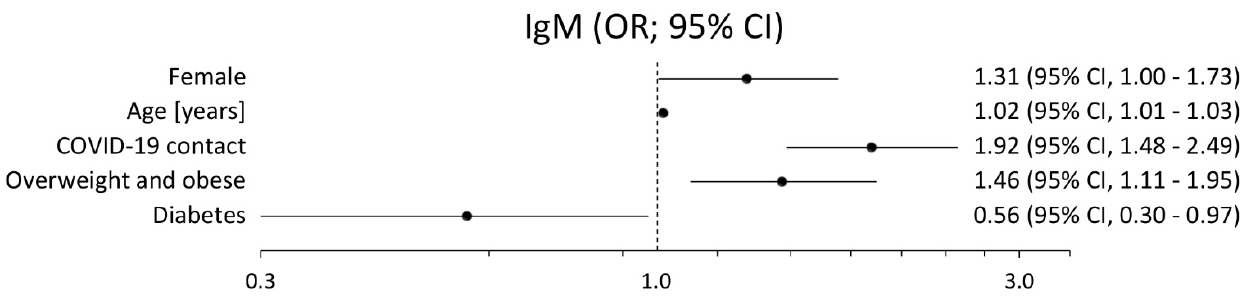
Figure 2. Results of the multivariable analysis (adjusted odds ratio and its 95% confidence interval) for the relationship between the positive results of the IgM test and particular classification variables.